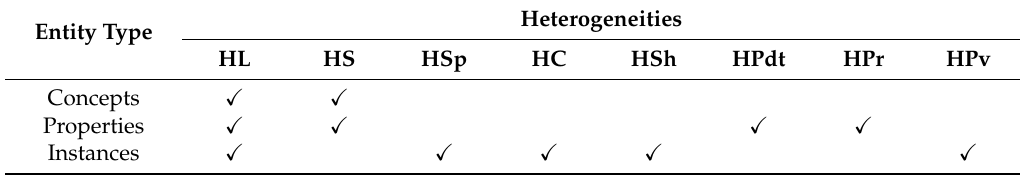
Table 2. Heterogeneities in each type of